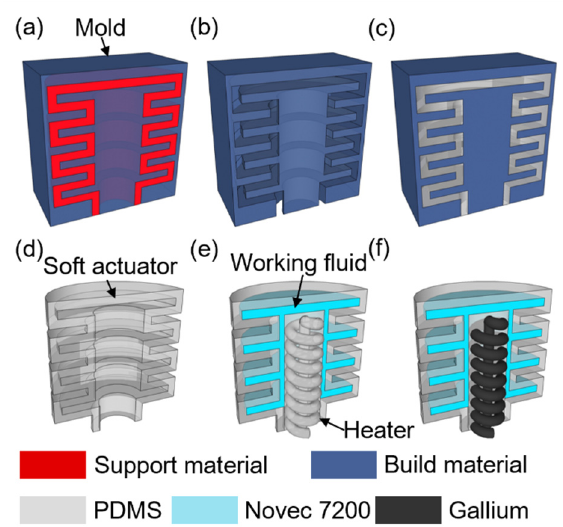
Figure 4. The fabrication process of the three-dimensional micro bellows actuator for the liquid–gas phase change mechanism: ( a ) The mold of the actuator is printed with the build and the support material. ( b ) The support material filled inside the mold is selectively removed by a dewaxing solvent. ( c ) Liquid PDMS is poured into the mold and cured in a convection oven. ( d ) The mold made of build material is dissolved with acetone, leaving the cast bellows actuator. ( e ) Working fluid and PDMS heater are sequentially inserted into the bellows actuator. ( f ) Liquid gallium is injected with a syringe into the channel of the PDMS heater to enable electrical conductivity. When the heater is heated due to the induced electromotive force by the receiving inductor, the working fluid inside the actuator evaporates and the internal pressure increases. The increased pressure causes the PDMS actuator to expand.